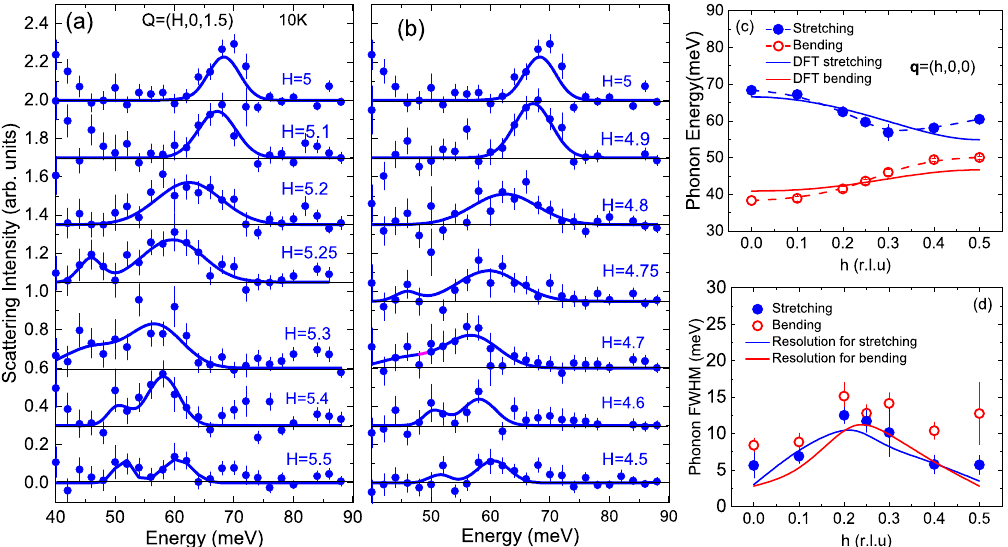
Figure 4. Cu-O bond-stretching and bond-bending longitudinal phonon dispersion along [100]. ( a , b ) Background-subtracted data at wavevectors with large bond-stretching phonon structure factor and small bond-bending structure factor. Binning: Δ H = ±0.07, Δ K = ±0.08, and Δ L = ±3.5. ( c ) Dispersions of the bond-stretching (blue) and bond-bending phonon branches (red). For the bond-stretching phonon peaks the multizone fit was made to the data at each q in the two zones shown in ( a , b ). The bond-bending (lower) branch peak positions were fixed to the values obtained based on wavevectors adjacent to (4,0,0), (4,1,0), and (4, − 1,0). ( d ) Raw-data peak widths (FWHM) extracted from the same fits as in ( c ). The e ff ective resolution width increases when the dispersion is steeper. (From Ref. [9]).